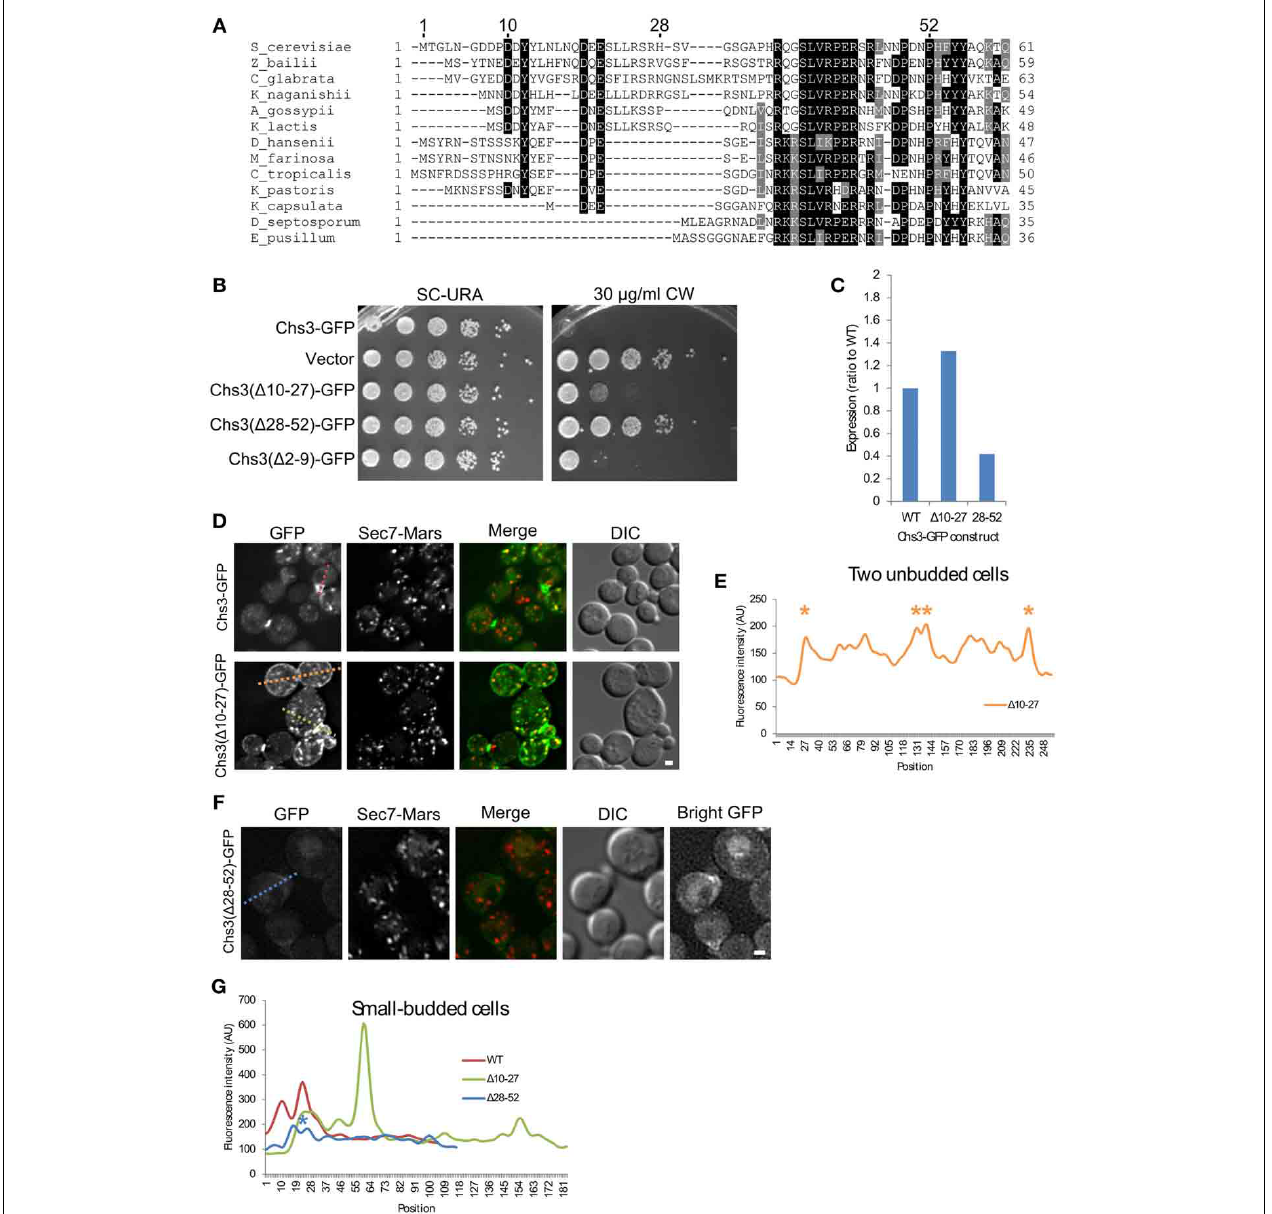
FIGURE 2 | Residues 10–27 and 28–52 are important for distinct trafficking steps. (A) Multiple sequence alignment of several Chs3 homologs. Residues are shaded to highlight similarity (gray) or identity (black). (B) The indicated plasmids were transformed into both a chs3 (cid:2) SEC7-Mars strain and a chs3 (cid:2) SEC7-Mars apl2 (cid:2) strain and plated on indicated media. Plates were imaged after 2 days at 30 ◦ C. See also Figure S2 for additional CW concentrations. (C) Protein expression level of mutated Chs3-GFP constructs relative to wild type as calculated from the α -GFP Western blots in Figure S1, normalized to loading